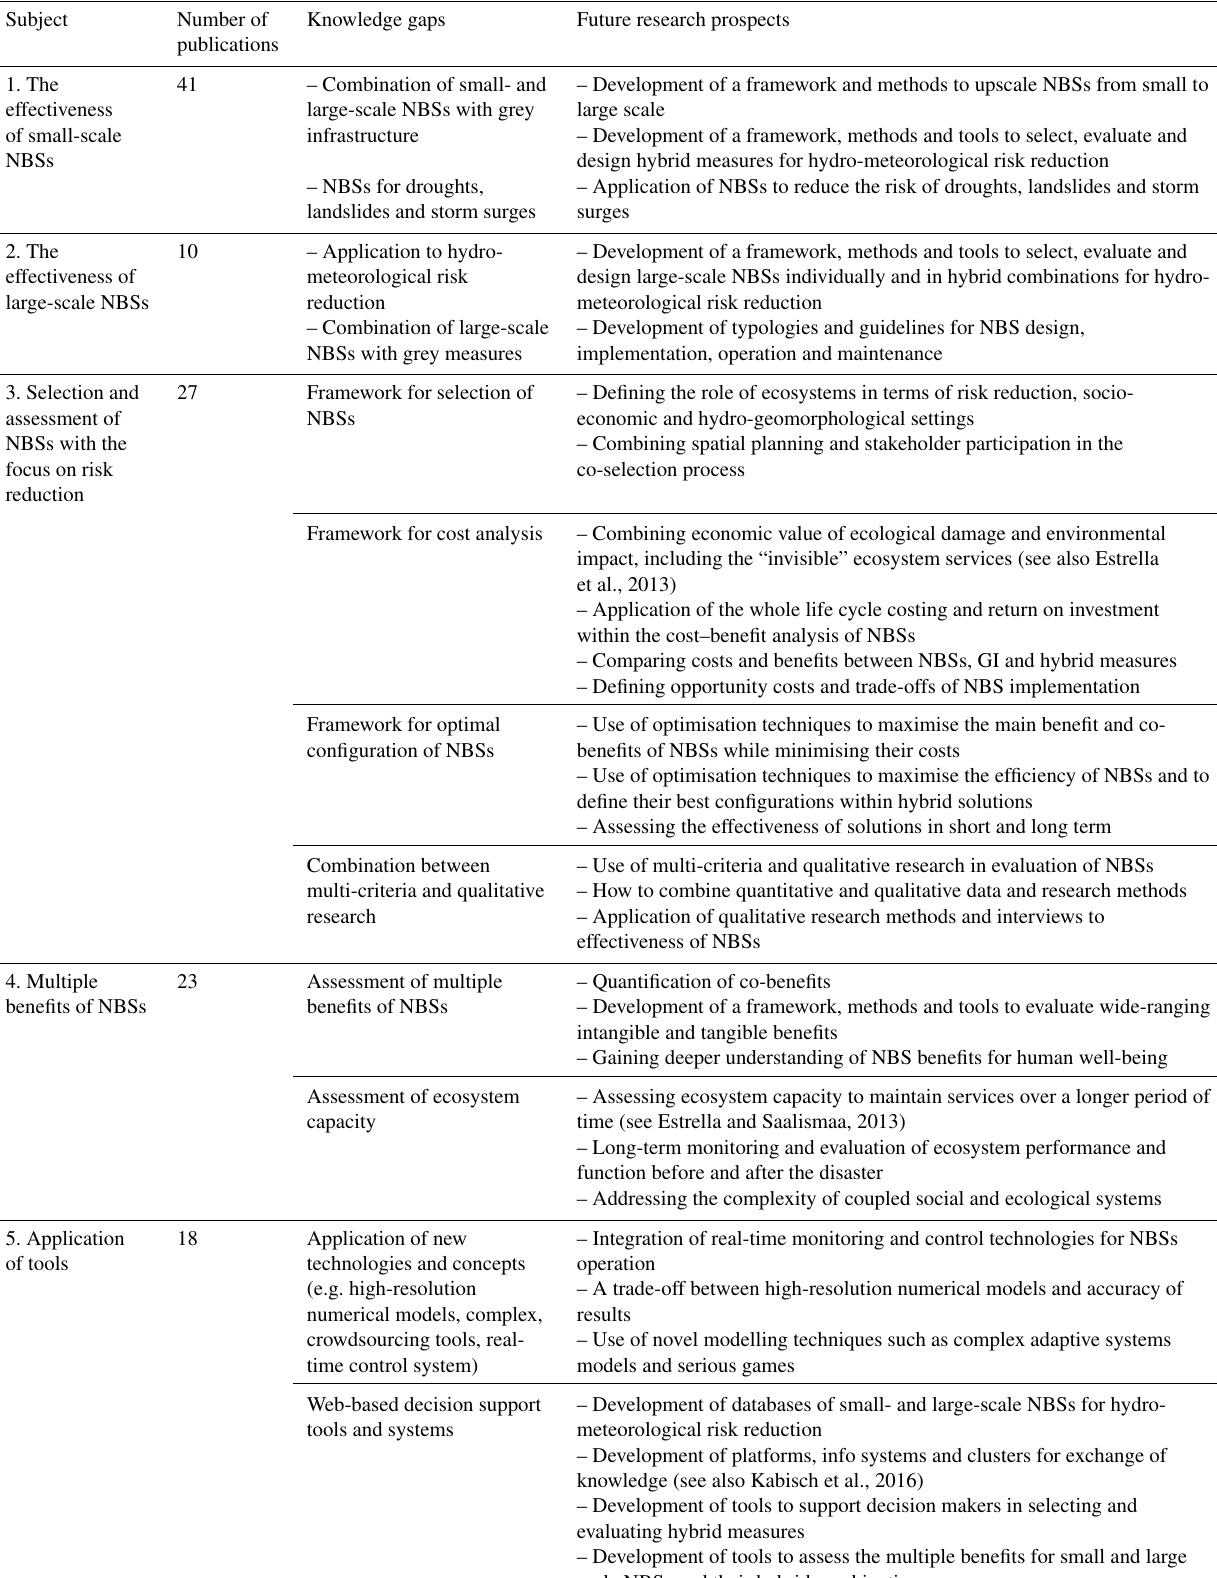
Table 5. Overview of knowledge gaps and potential future research